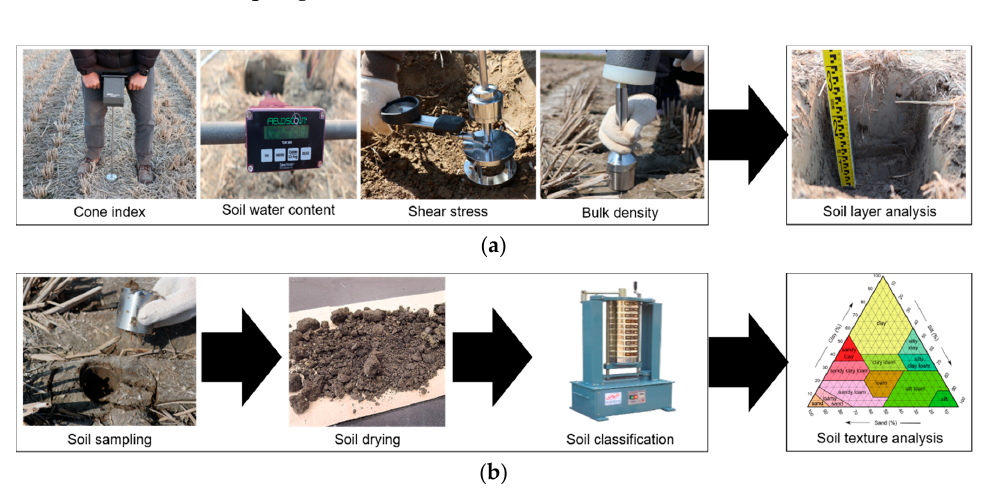
Figure 2. Test procedure for measuring soil properties: ( a ) soil layer analysis process by measuring cone index, soil water content, shear stress, and bulk density; ( b ) soil texture analysis process through soil sampling, soil drying, and soil classification.